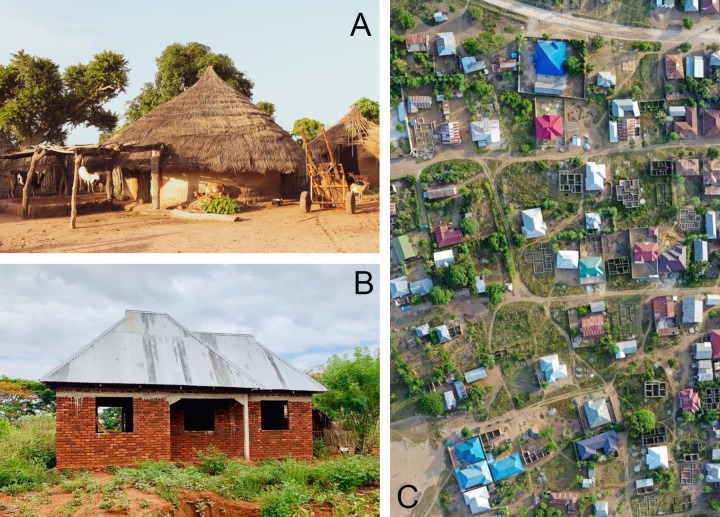
Housing development in sub-Saharan Africa.(A) Traditional, thatch-roof house in Upper River Region, The Gambia. (B) Modern building under construction in Tanga, Tanzania. (C) Incremental house construction in suburban Tanga, Tanzania. Houses range from approximately 20 years old with rusted roofs to new homes with coloured roofs. New foundations are also visible. Photographs were taken by Jakob Knudsen.